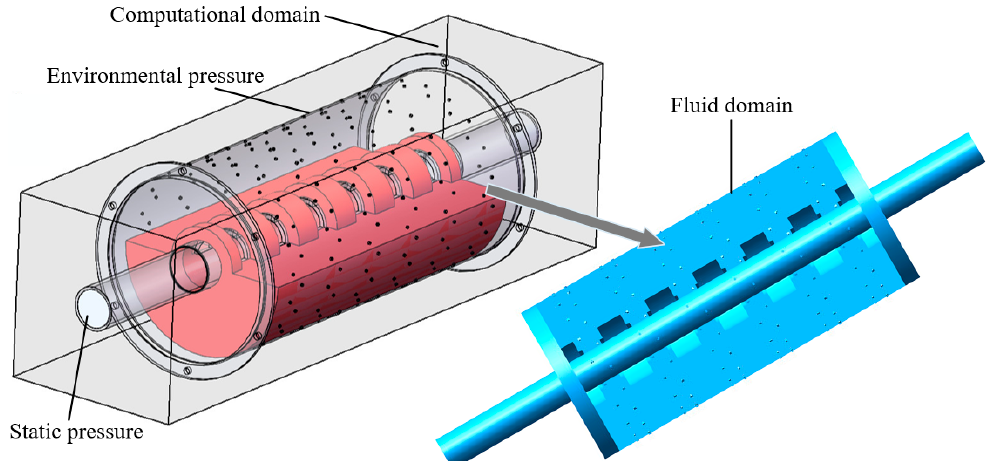
Figure 4. Simulation model of the flow field of a seed dispenser.